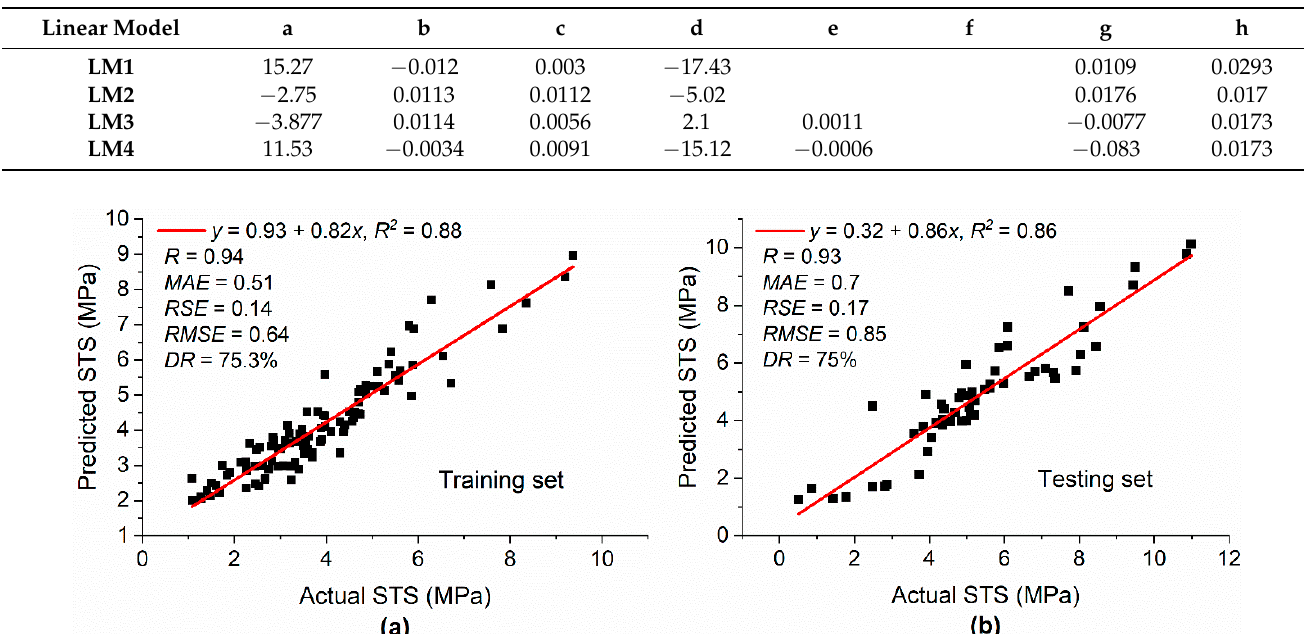
Figure 8. Actual and predicted values of STS: ( a ) training set; ( b ) testing set.